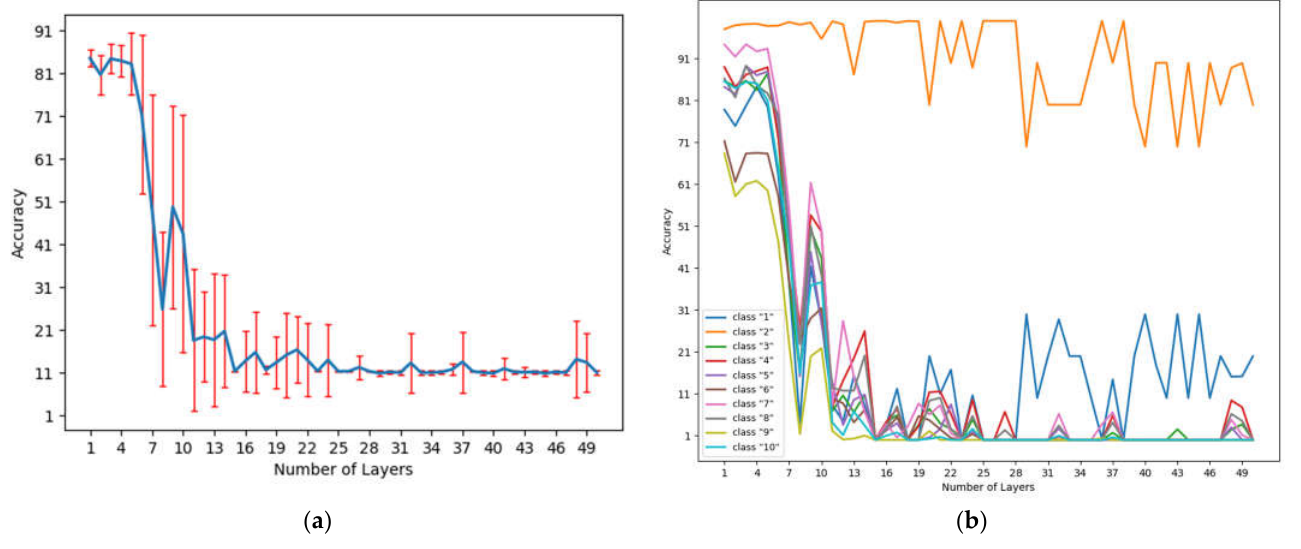
Figure 6. MNIST dataset performance results. ( a ) Accuracy achieved by the plain-50 network with respect to different depths using the MNIST dataset; ( b ) Per-class accuracies achieved by the plain-50 network with respect to different depths using the MNIST dataset.